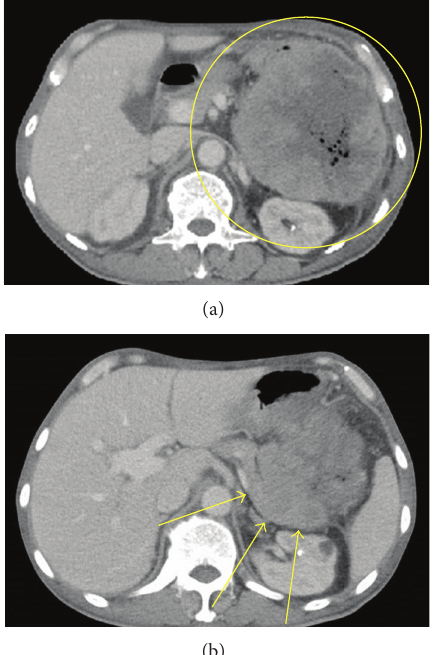
Figure 1: Preoperative abdominal computed tomography. (a) A large tumor (10.6 × 11.6cm; enclosed by yellow circle) at the splenic flexure with an irregularly thickened wall and involving the tail of the pancreas; (b) tail of the pancreas (arrows).